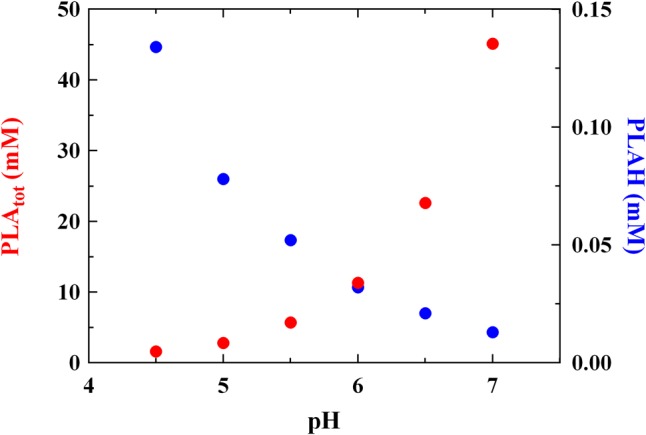
Minimum inhibitory concentration (MIC, mM) of total (PLAtot) and undissociated (PLAH) phenyllactic acid against Listeria innocua ATCC 33090 detected in BHI at different pH values.